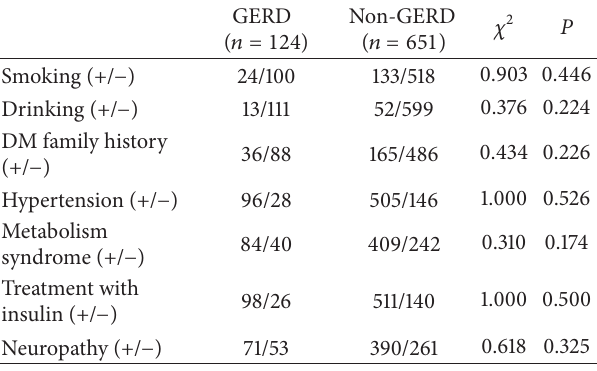
Table 3: Comparison of interview indicators and neuropathy be- tween the two